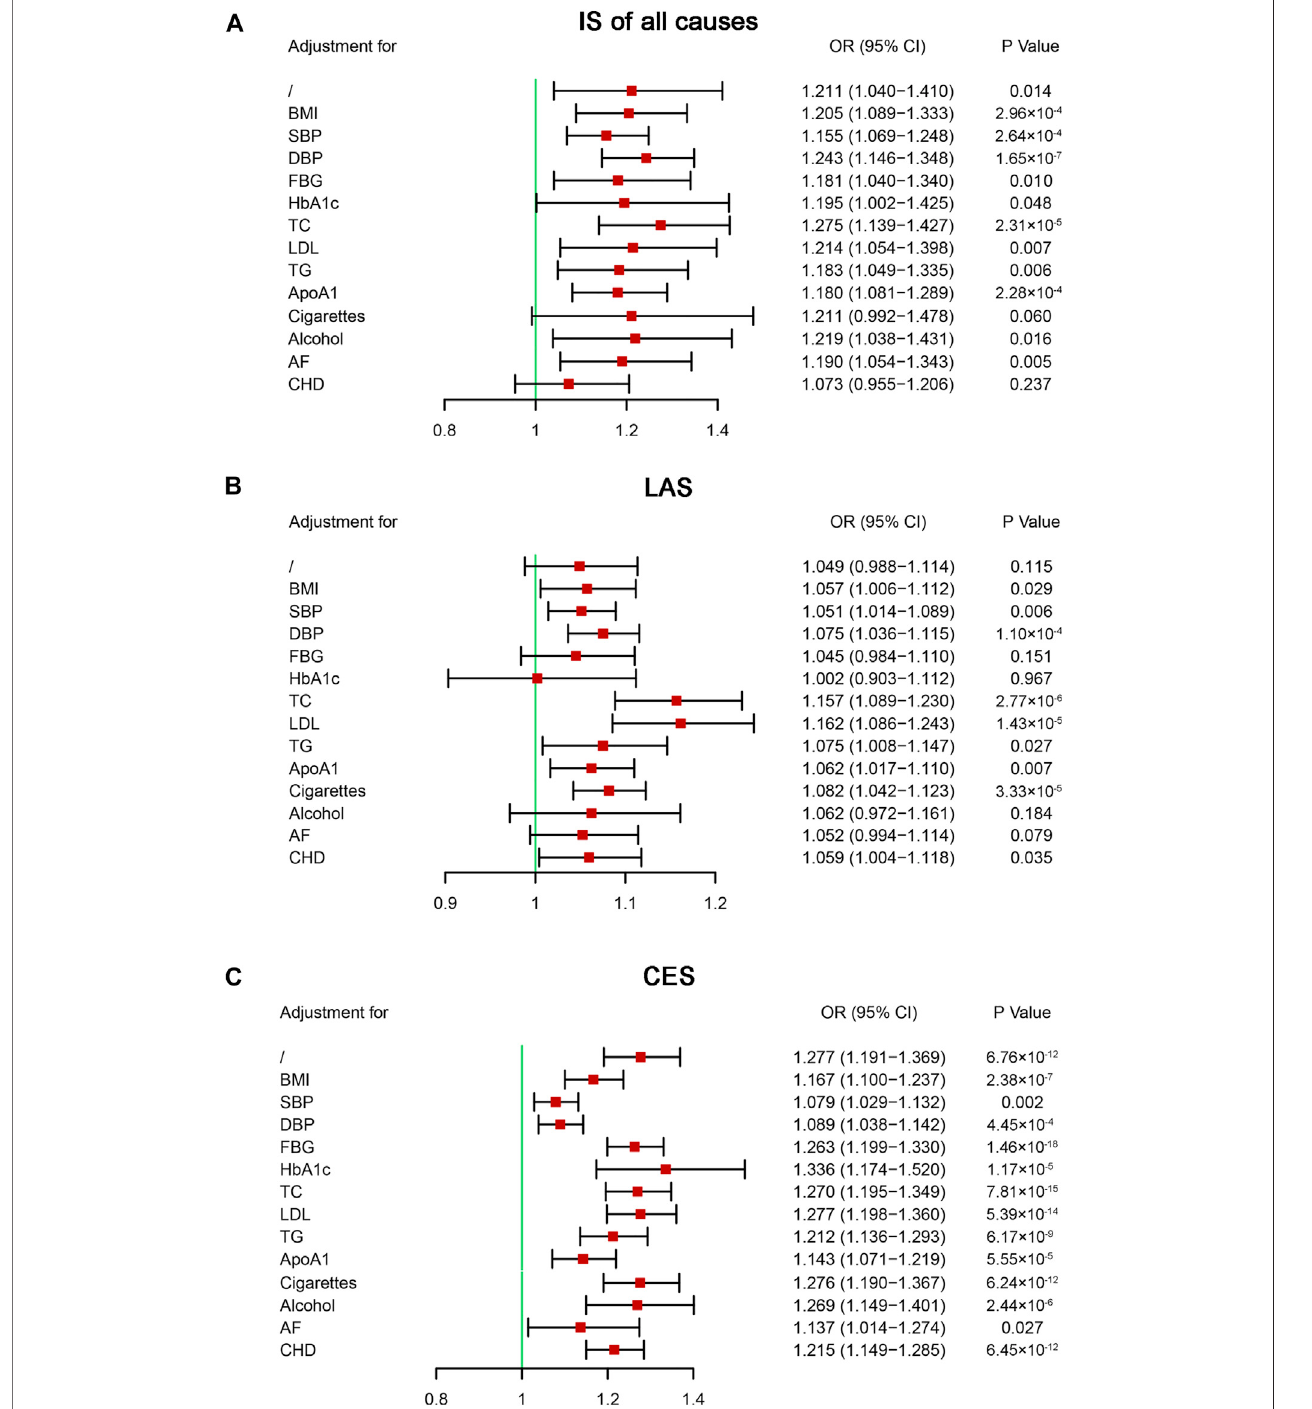
FIGURE 5 | Multivariable Mendelian randomization analysis of the effect of ischemic stroke on heart failure. ApoA1, apolipoprotein A-1; AF, atrial fi brillation; BMI, bodymassindex; CES,cardioembolicstroke;CHD,coronaryheartdisease;CI,con fi dential interval;DBP,diastolicbloodpressure;FBG, fastingblood glucose;HbA1c, glycosylated hemoglobin; IS, ischemic stroke; LAS, large artery atherosclerosis stroke; LDL, low-density lipoprotein cholesterol; OR, odds ratio; SBP, systolic blood pressure; TC, total cholesterol; TG, triglyceride; SNP, single nucleotide polymorphism.